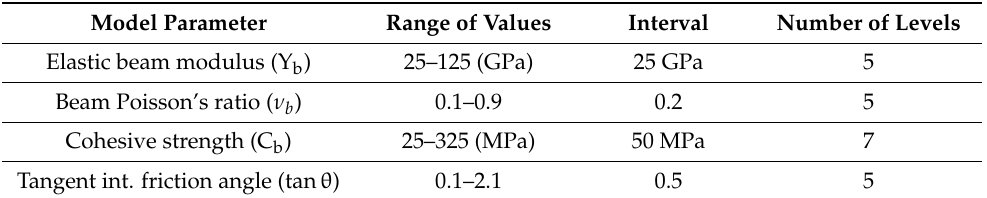
Table A1. Range of values of model parameters utilised for the